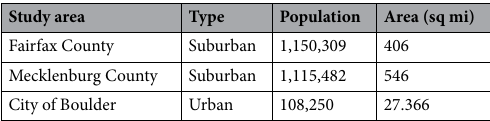
Table 2. Characterization of the study areas.